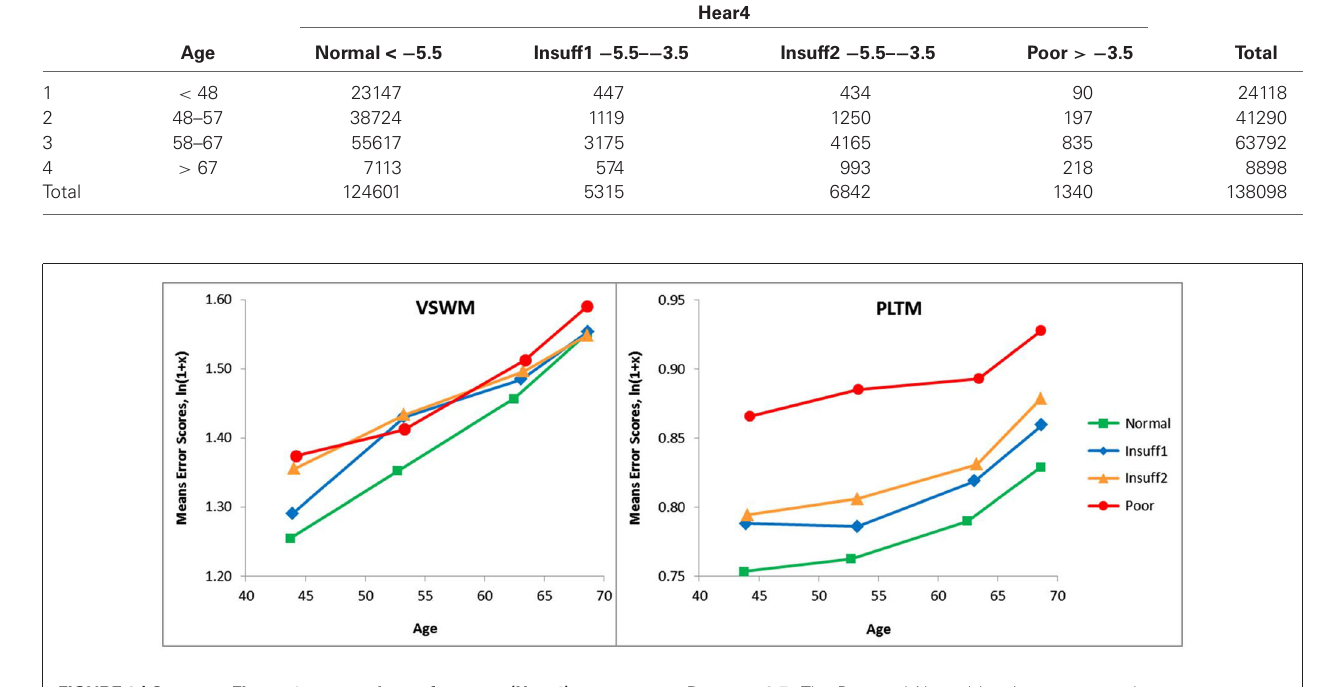
FIGURE 3 | Same as Figure 1 except that a four-step (Hear4) hearing grouping was employed. Categories in SRT dB: Normal = < − 5.5 Insuff1 = − 5.5 to − 5.0, Insuff2 = − 5.0 to − 3.5